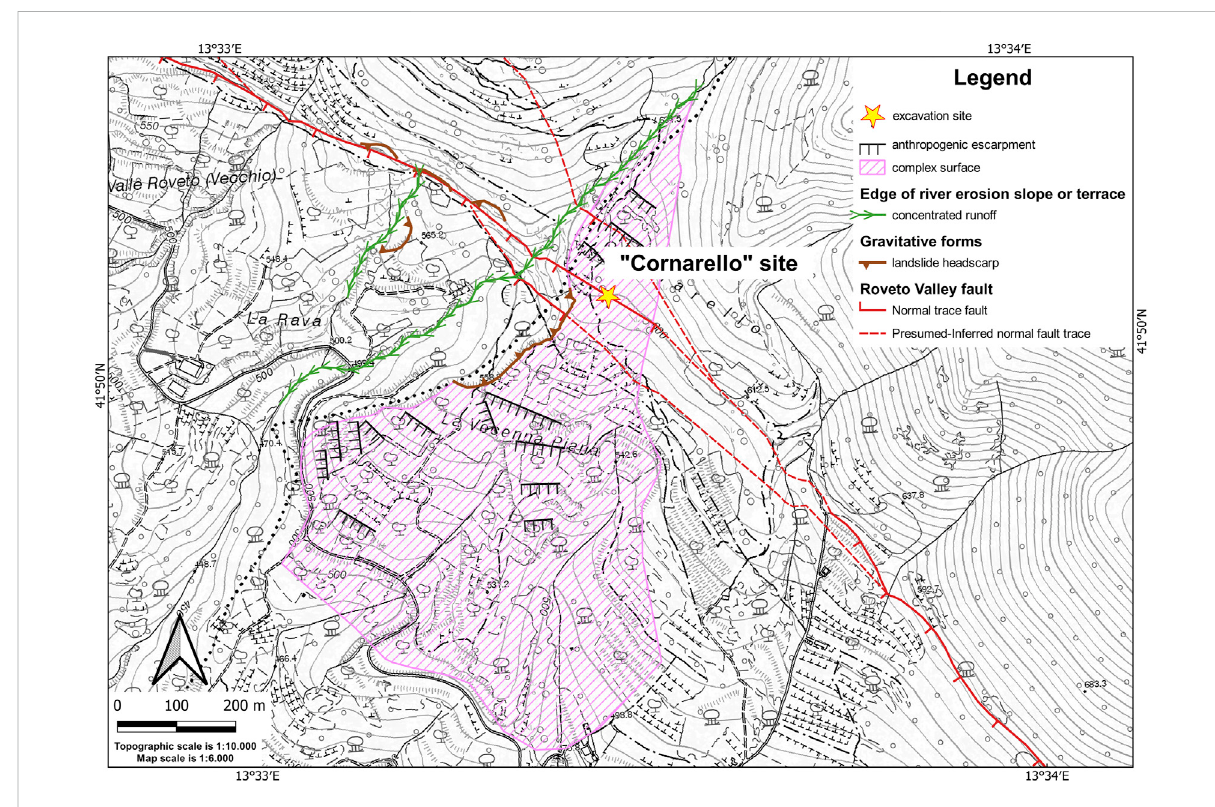
FIGURE 10 Geomorphologicschemeofthe “ Cornarello ” site.Topographicmap(scale1:10.000)fromopengeodataoftheAbruzziRegion(http://opendata. regione.abruzzo.it/content/dbtr-regione-abruzzo-scala-110000-edizione-2007-formato-ecw).